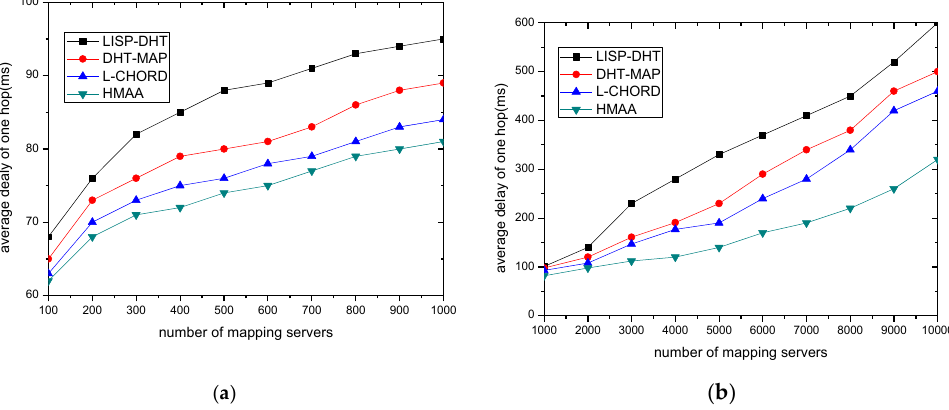
Figure 7. Average delay of one-hop: ( a ) small scale networks; and ( b ) large-scale networks.